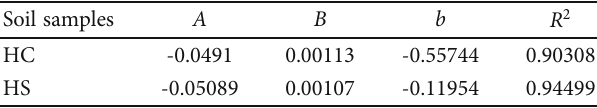
Figure 18: The change rate of deformation and time fi tting curve of soil HS. Table 4: The change rate of deformation and time fi tting parameter value of saline soil.